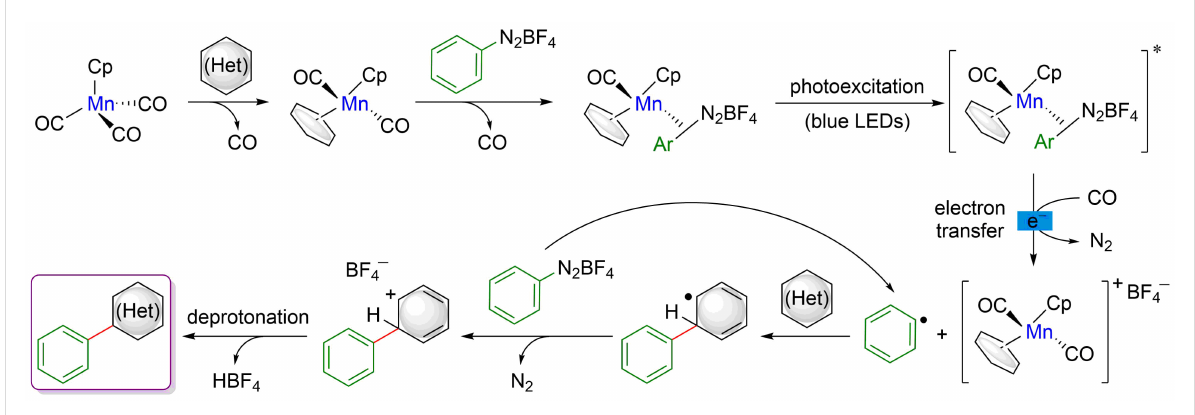
Figure 45: Proposed mechanism for the undirected arylation of (hetero)arenes via dual catalysis.